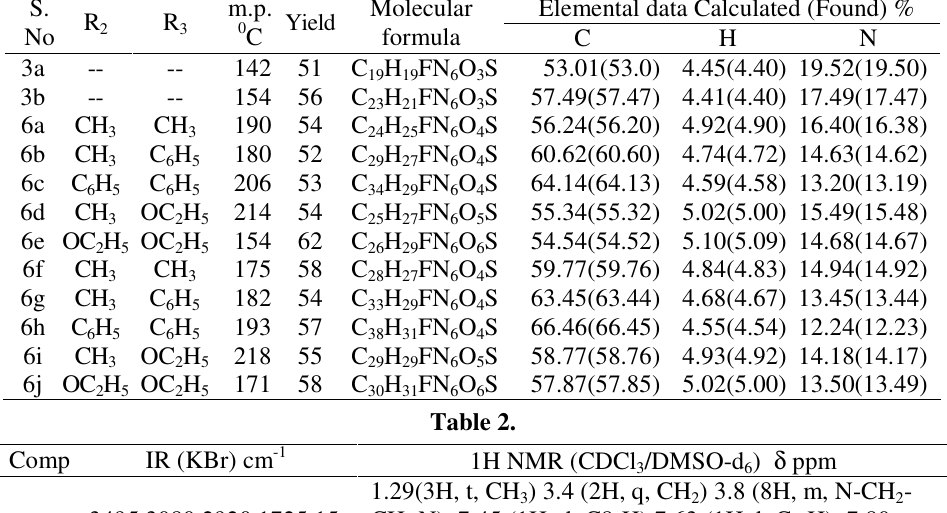
Table 1. Substitution pattern and physical properties for novel norfloxacin derivatives (3a-b, 6a-j)